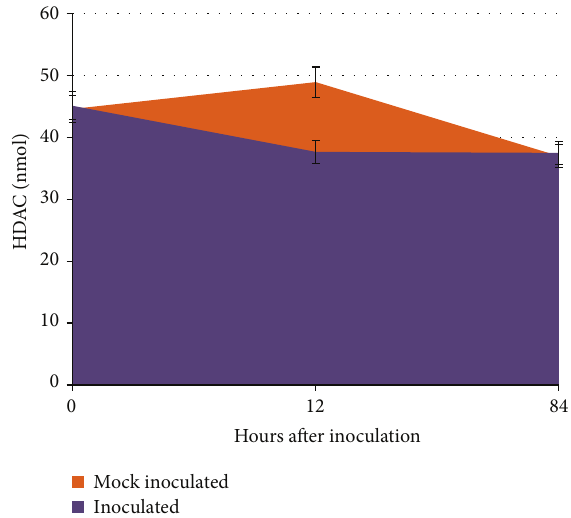
Figure 3: HDAC activity between mock inoculated and inoculated common bean. Total HDAC activity was measured based on the optical density (OD) and the amount of activity was determined based on the standard curve. The experimental values differ signif- icantly with a probability value of 0.05%. The error bars represent standard